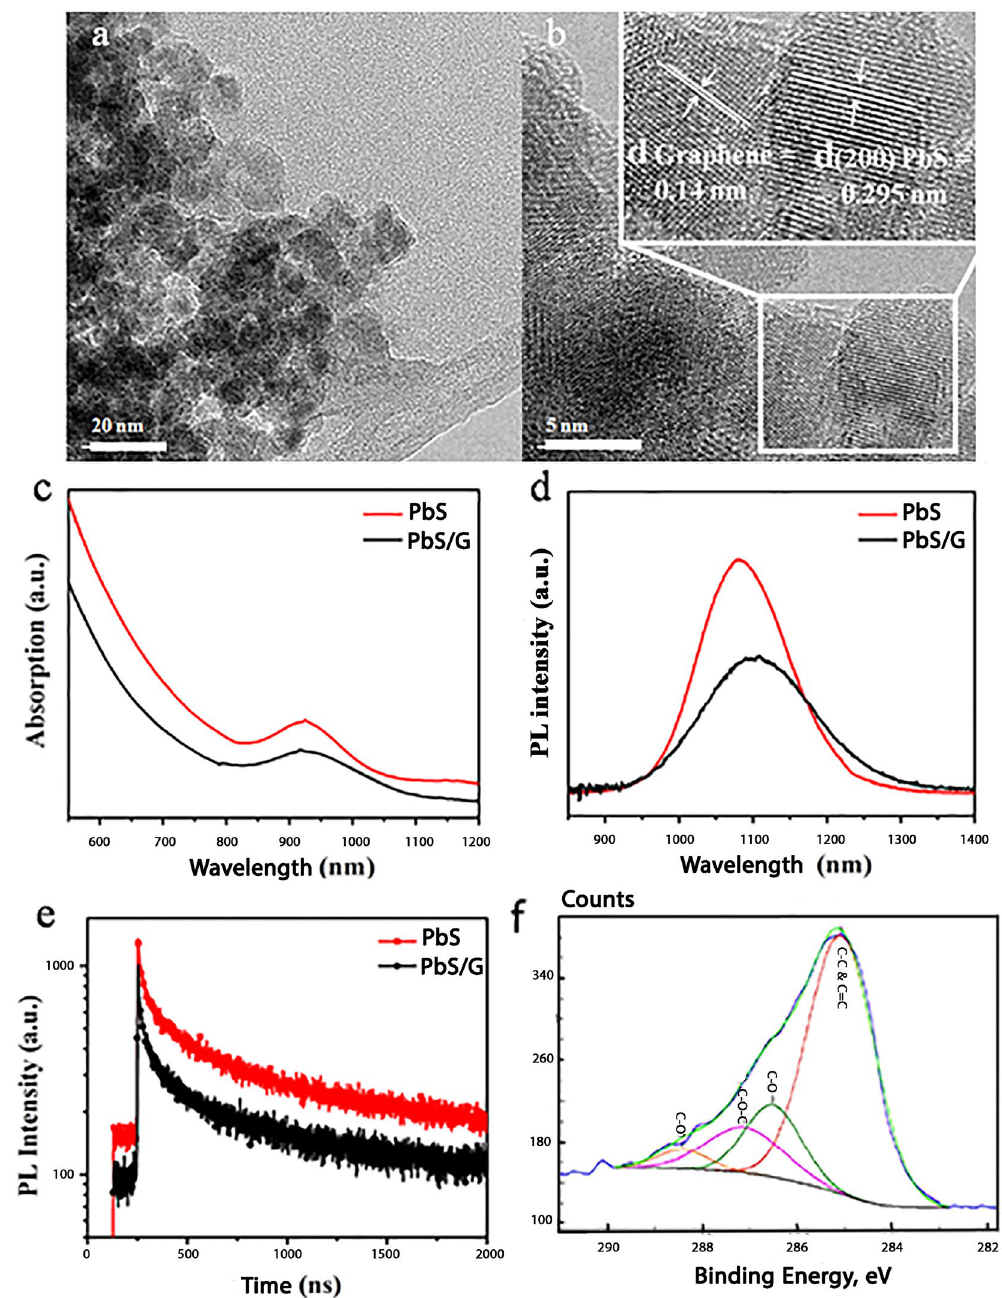
Figure 1. Characteristics of heterostructure semiconductor nanocrystals: ( a , b ) TEM images of the quantum dots. ( c ) UV-Vis spectra show a relatively broad absorption peak at around 940 nm. ( d ) Steady-state and ( e ) TRPL measurements indicate NIR emission at around 1100 nm with relatively long carriers’ lifetime. ( f ) Deconvoluted XPS C1s spectra reveal surface functional groups of the prepared